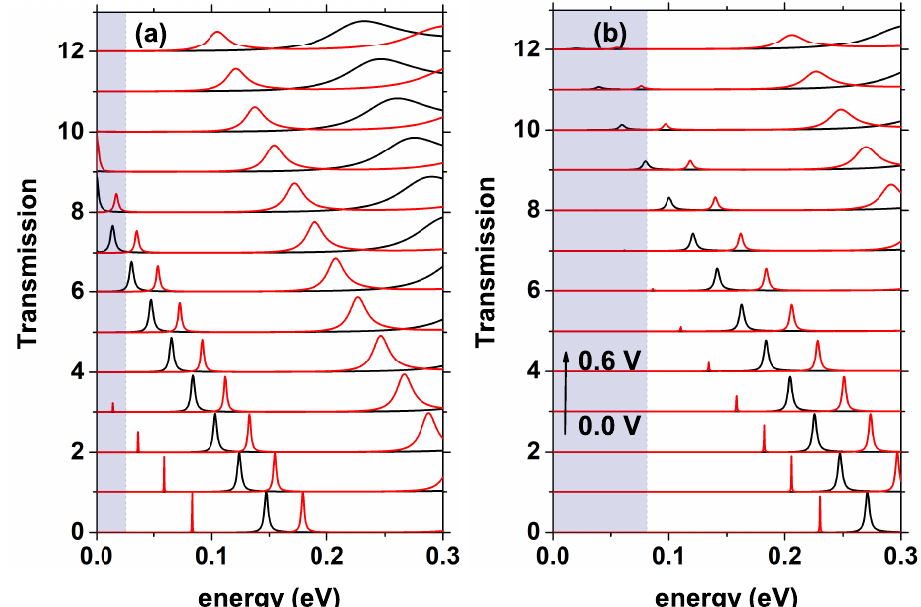
Figure 5. Transmission coefficient for different values of bias voltage, the black curve is for L w = 4 nm and, the red curve is for L w = 10nm. ( a ) with n d fixed at 1.2 × 10 18 [1/cm 3 ] and ( b ) with n d fixed at 10 × 10 18 [1/cm 3 ]. The shaded area indicates the region between the bottom of the conduction band and the quasi-Fermi level at the emitter. As indicated by the arrow in ( b ), the voltage for each curve varies from 0.0V to 0.6V in steps of